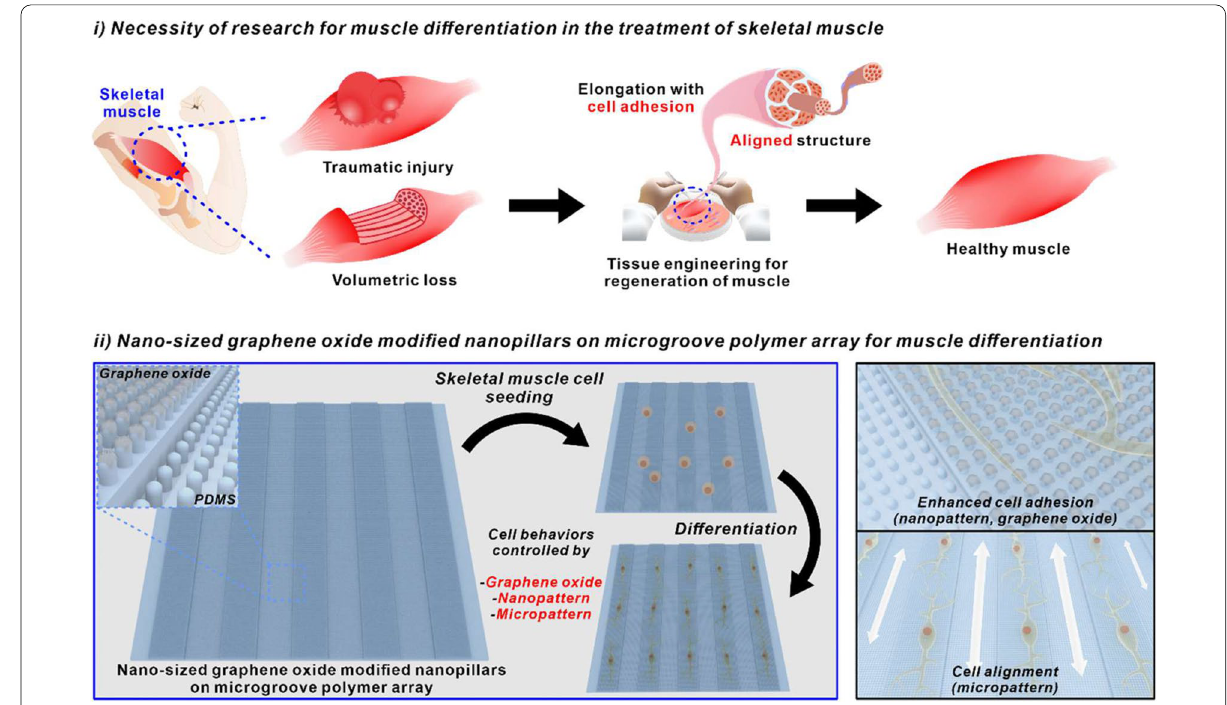
Fig. 1 Schematic diagram of necessity of research for muscle differentiation in the treatment of skeletal muscle and nano‑sized graphene oxide‑modified nanopillars on microgroove polymer array for muscle